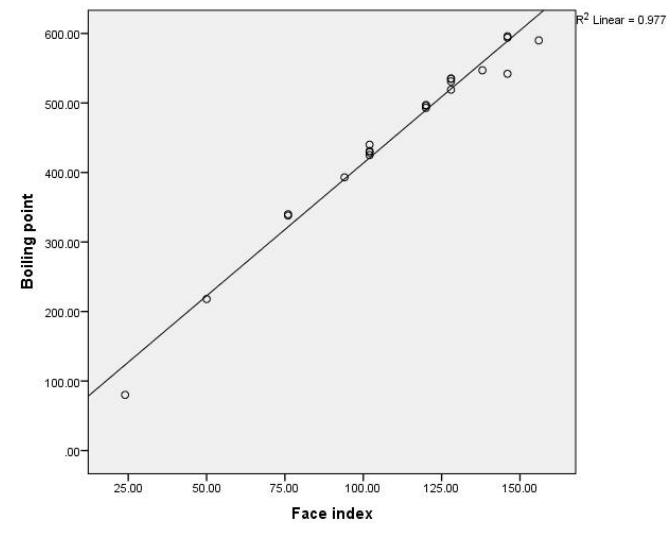
Figure 6. The linear correlation between the first face index and the boiling points for benzenoid